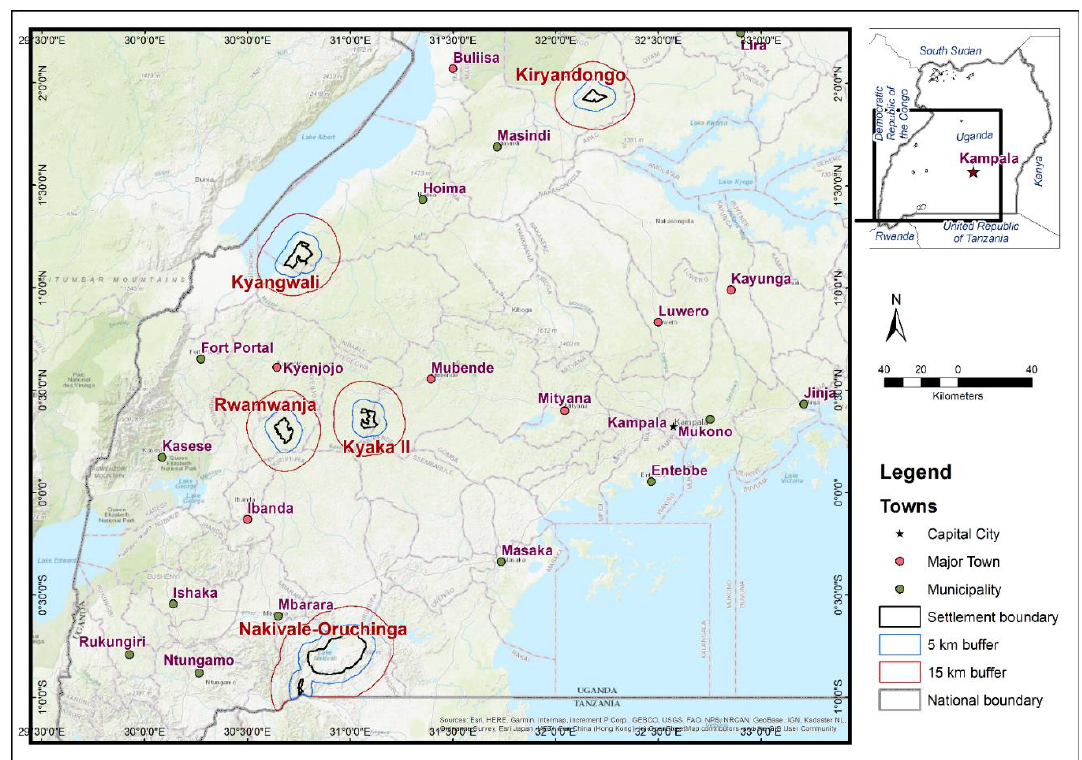
Figure 2. Target refugee settlements and areas of interest in western and southwestern Uganda. Note: The boundaries, names, and designations on these maps do not imply official endorsement or acceptance by the United Nations.